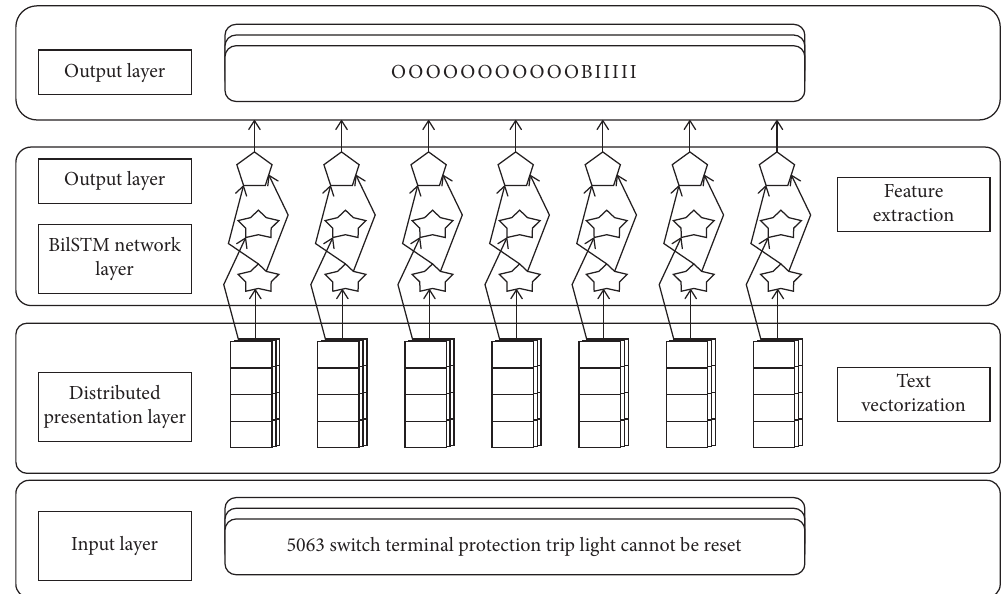
Figure 3: CAD-aided intelligent operation and maintenance model architecture of power system equipment.